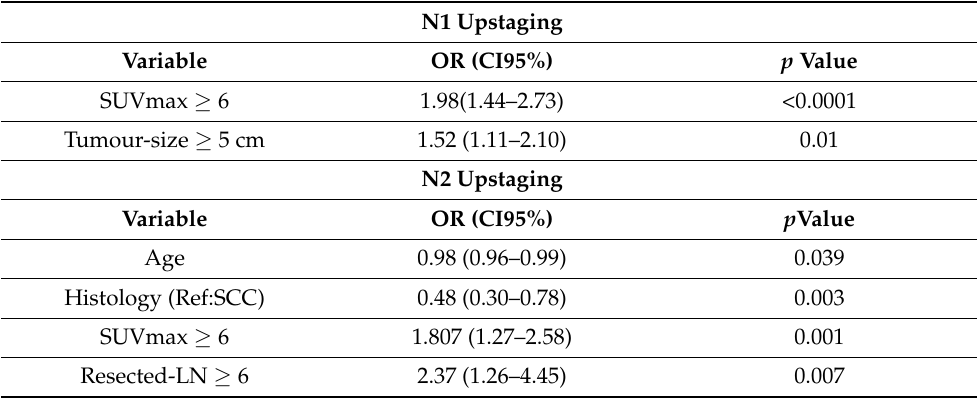
Table 3. Multivariable analysis for unforeseen pN1 and pN2.